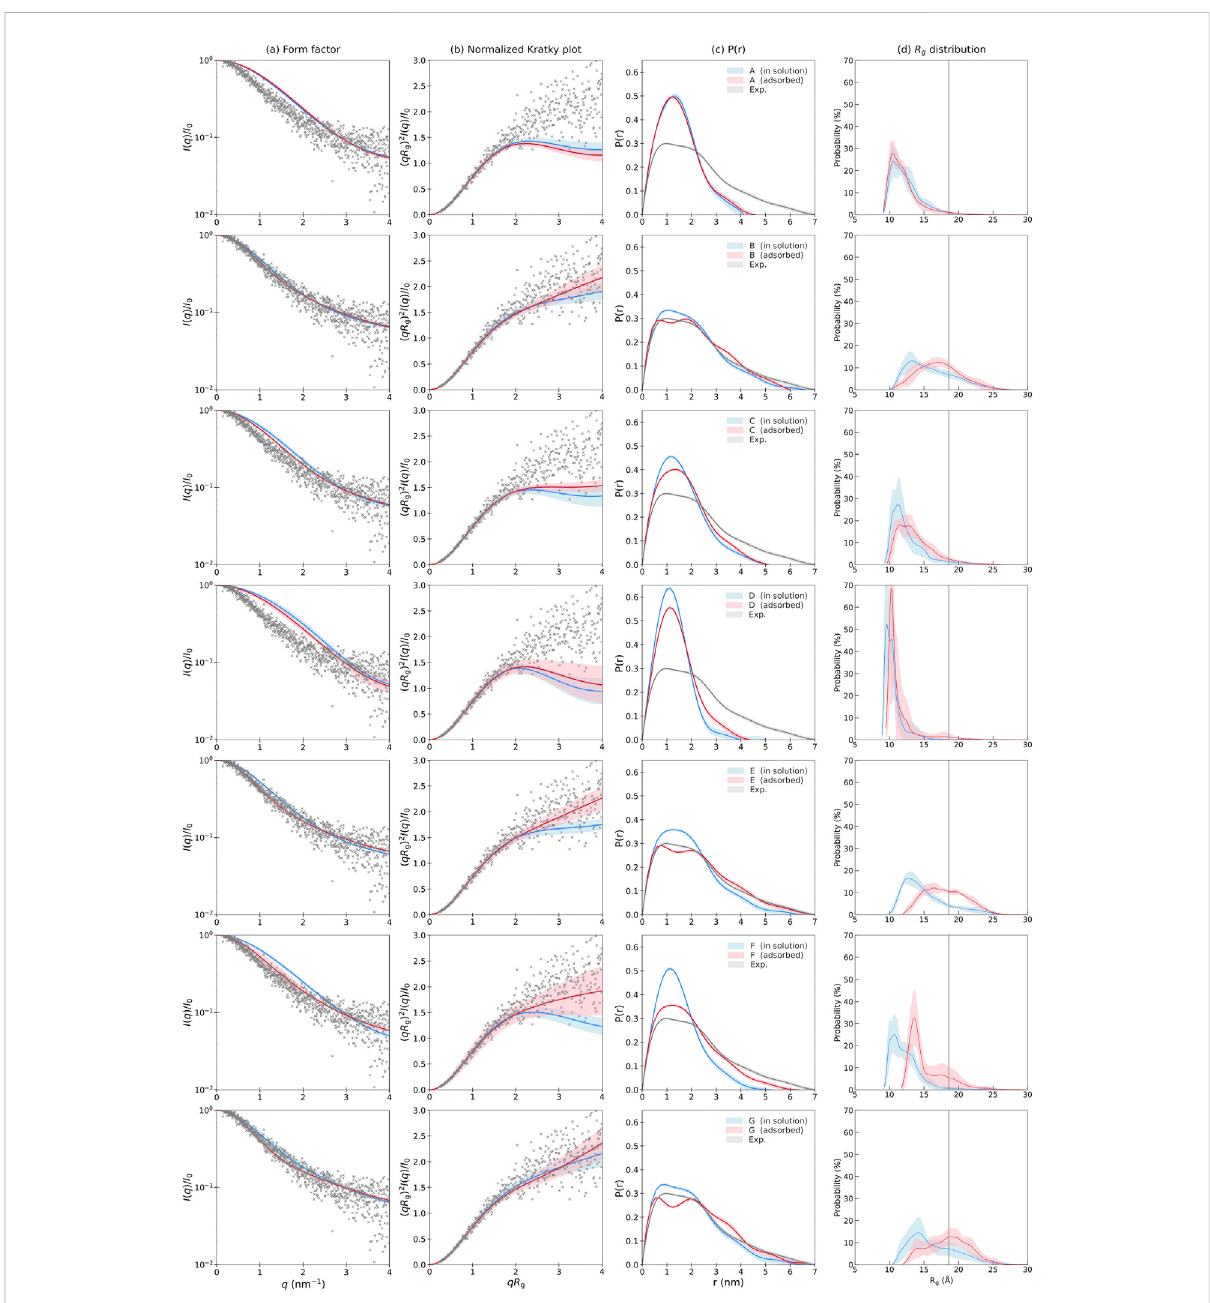
FIGURE 1 (A) Form factor, (B) normalized Kratky plot, (C) pair distance distribution, and (D) radius of gyration distribution for KEIF in solution (blue) and adsorbed(red)forthedifferentforce fi eldandwatermodelcombinations,withshadedareasrepresentingthestandarddeviationbetweenreplicates. Experimental SAXS results are included for KEIF in solution (gray) as described by Jephthah et al.